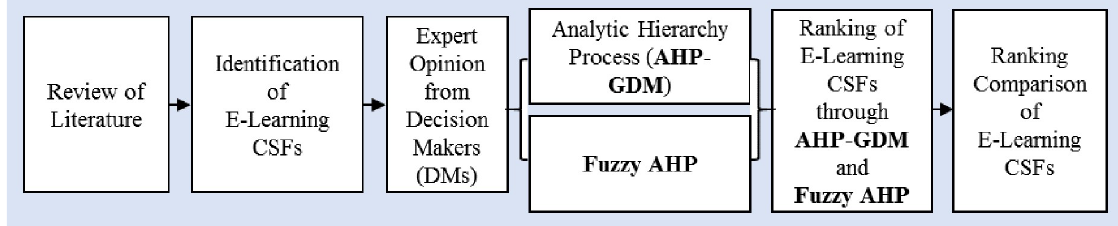
Fig 1. AHP-GDM and FAHP based framework for ranking CSFs of E-Learning.